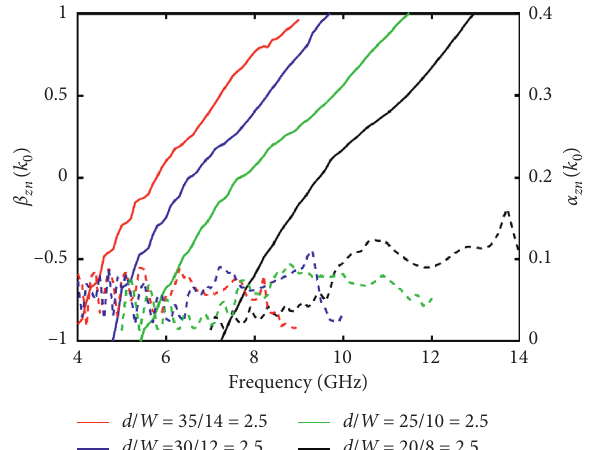
Figure 10: The normalized propagation constant of different parameters when d / W � 2.5.